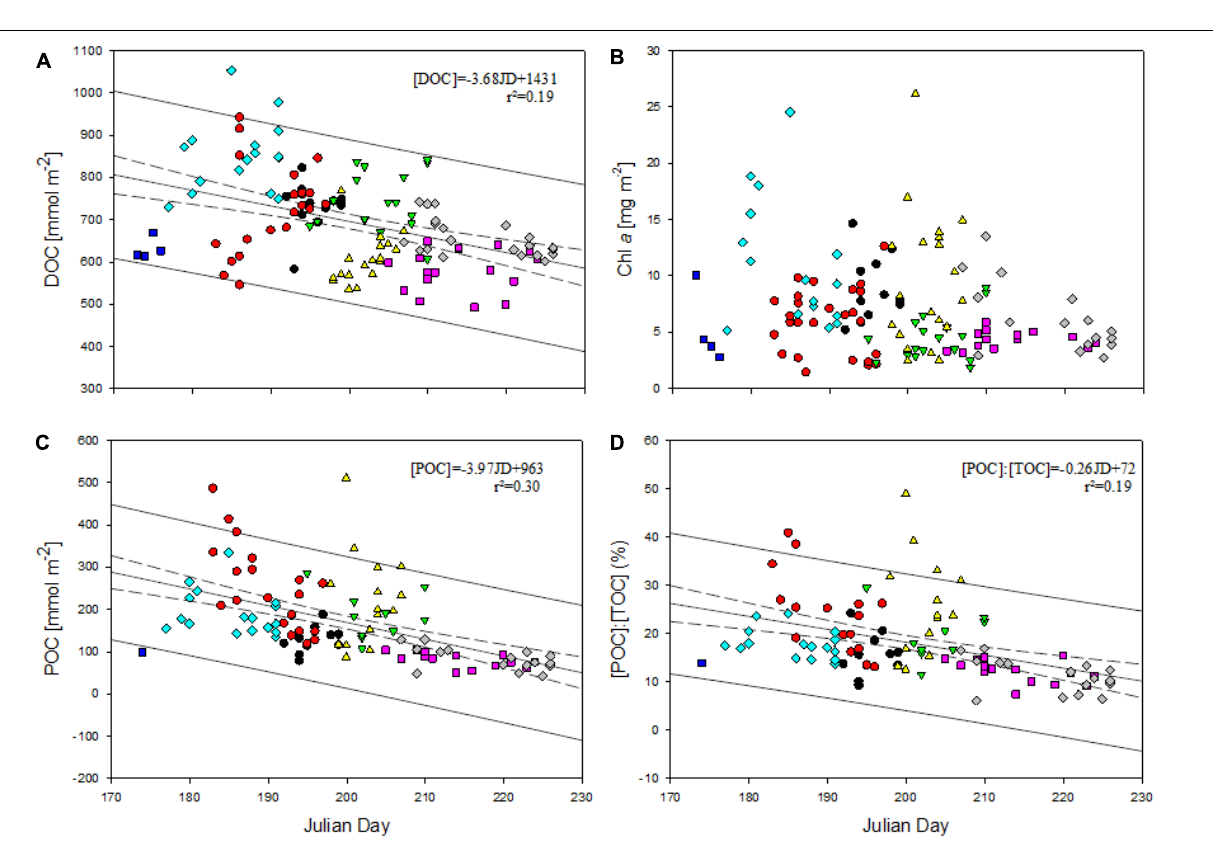
Frontiers in Marine Science |